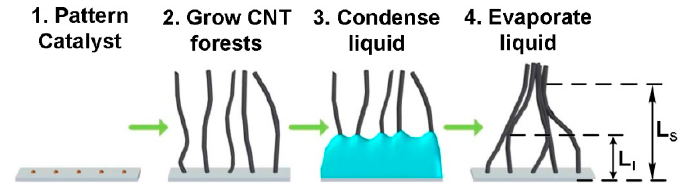
Figure 3. Successive steps used in the CNT capillary self-assembly process. Reproduced from [29], courtesy of Michael De Volder.